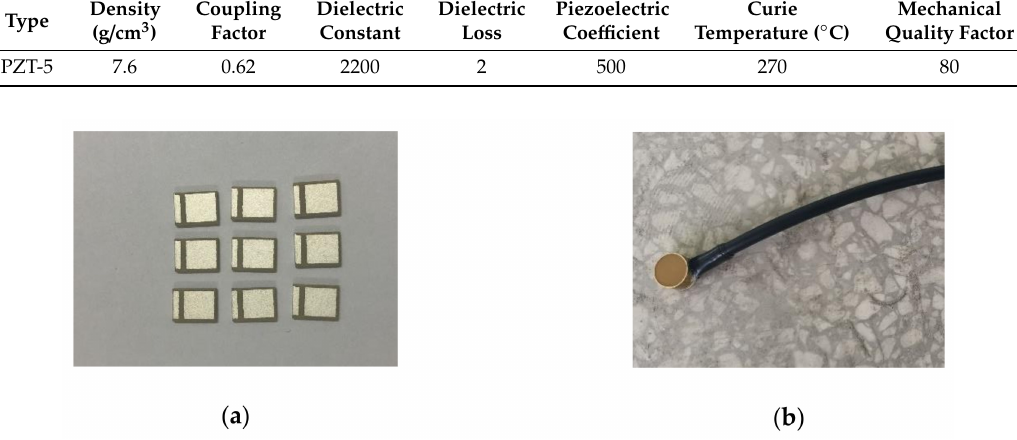
Figure 3. ( a ) PZT patches; ( b ) epoxy-resin-wrapped PZT